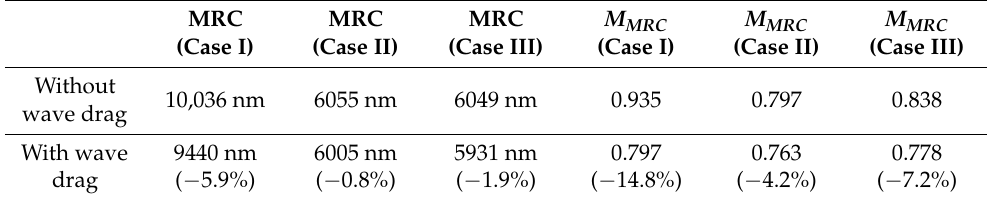
Figure 4. MRC and MRC airspeed for three fuel-laws tested—(b), (c), and (d)—for both cases, with and without transonic wave-drag model. Table 4. Fuel law-dependence of MRC and MRC Mach number ( M MRC ) for both cases, with and without transonic wave-drag